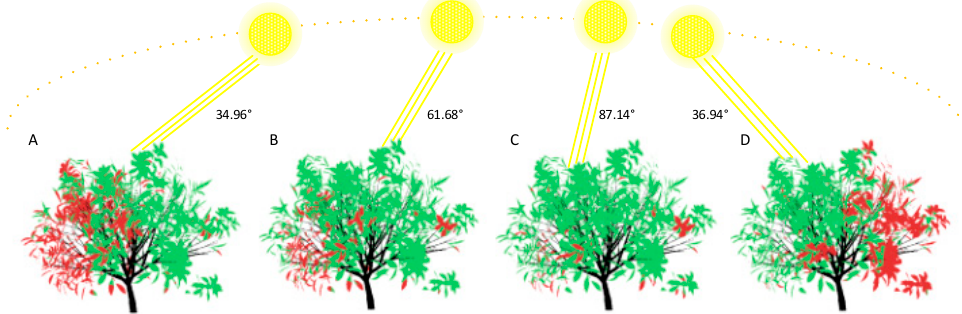
Figure 12. The distribution of the low-efficacy light area in the virtual loquat canopy on June 21, 2016. The yellow round symbols illustrate the light source, and the yellow lines illustrate the direction of the light. The figure in the diagram illustrates the elevation angle. The area with red leaves denotes the low-efficacy light area, whereas the area with green leaves denotes the active light area. ( A ) 8:00 ( B ) 10:00 ( C ) 12:00 and ( D ) 16:00. ISPRS Int. J. Geo-Inf. 2017 , 6 , 405 The average low-efficacy light area accounts for 17.73% of the entire canopy during the daytime.